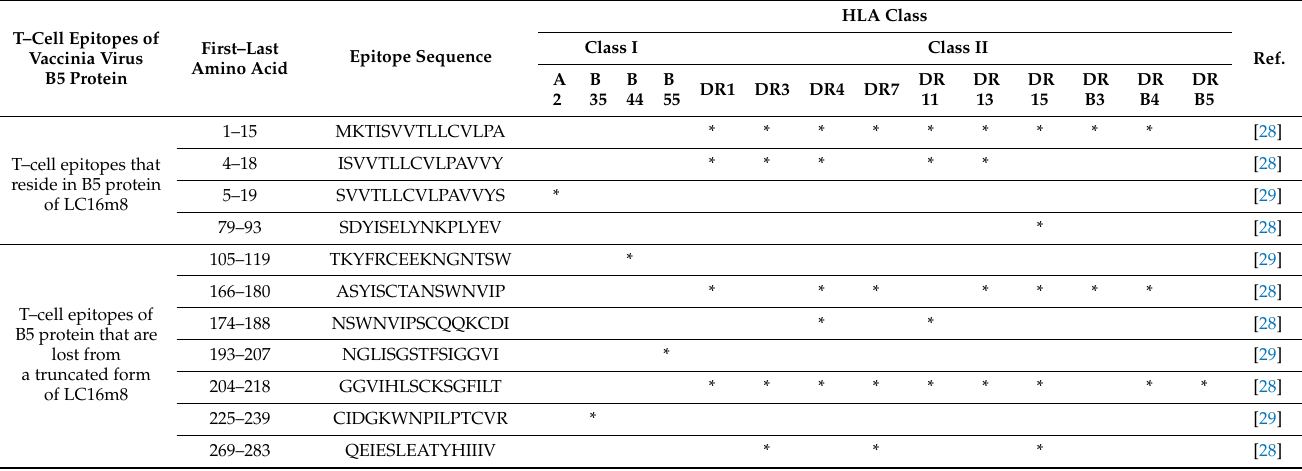
Table 1. T-cell epitopes in B5